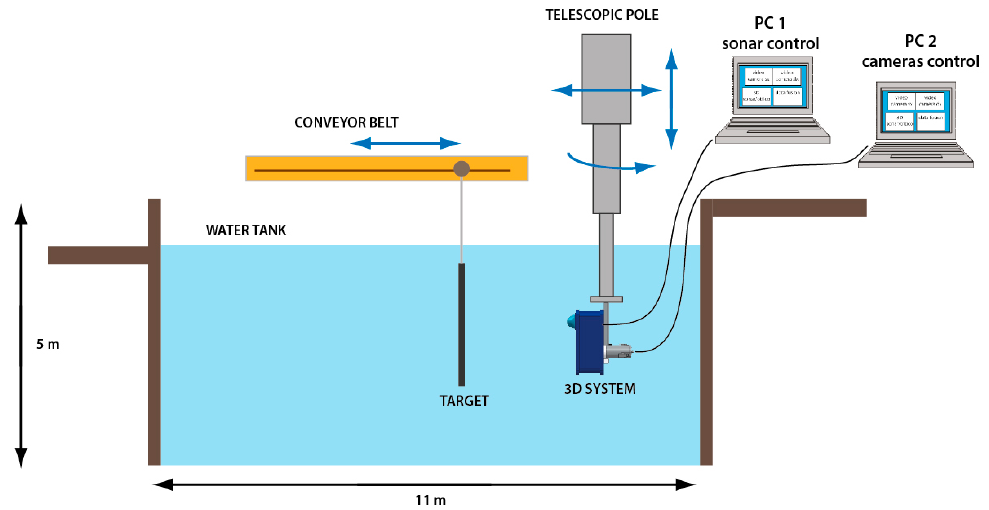
Figure 5. Experimental setup developed at the WASS electro-acoustic lab.